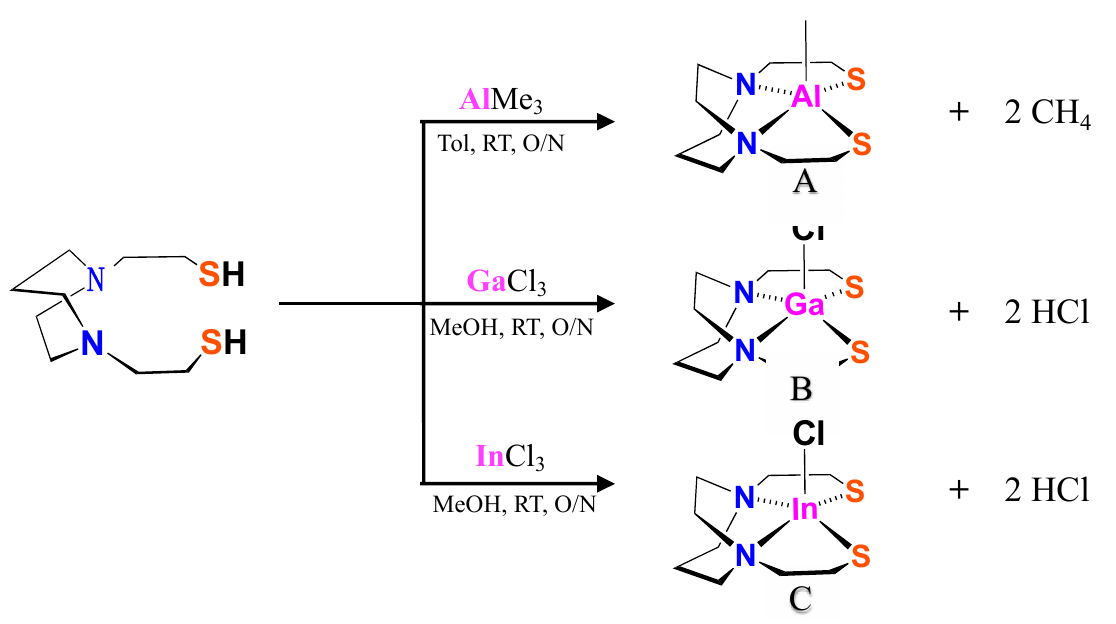
Figure 3. Synthetic routes for XMN 2 S 2 complexes; RT is ca. 22 °C and O/N is ca. 14 h.